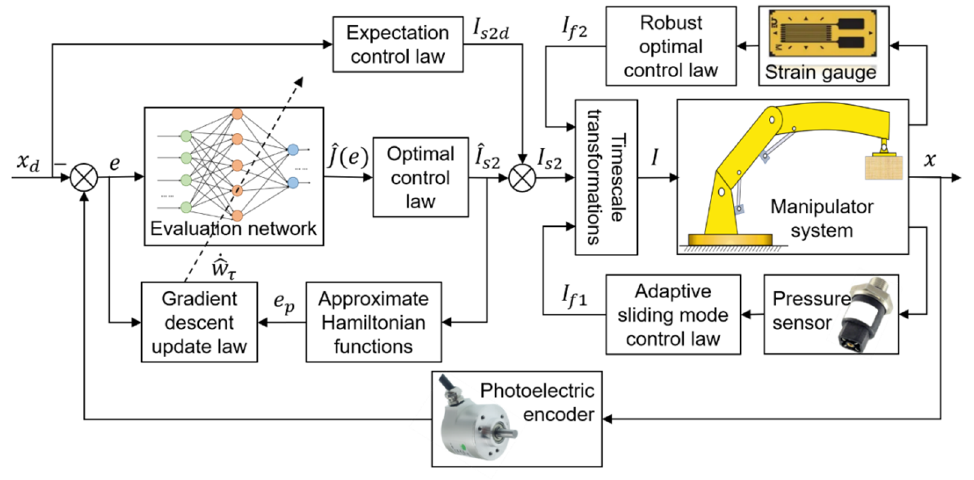
Figure 6. Block diagram of HDFRMS with controllers.